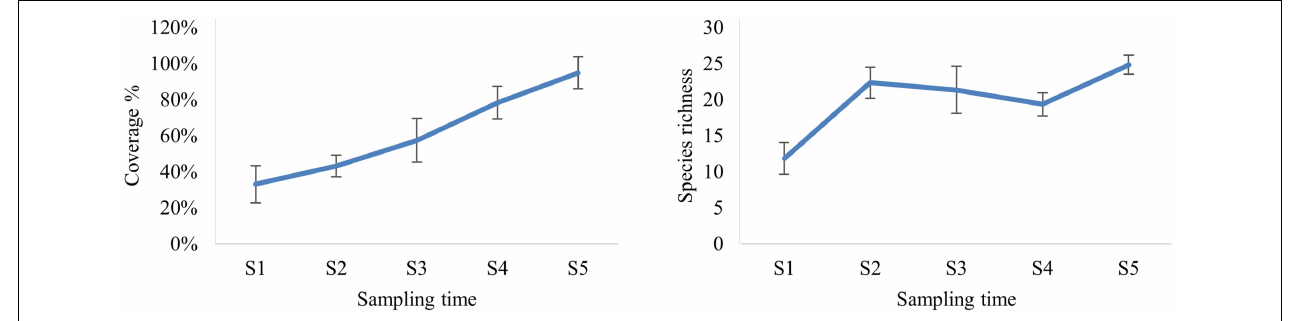
FIGURE 2 | The trend over time of total percent coverage (left) and the number of macrofouling species (right) on vertical collectors.